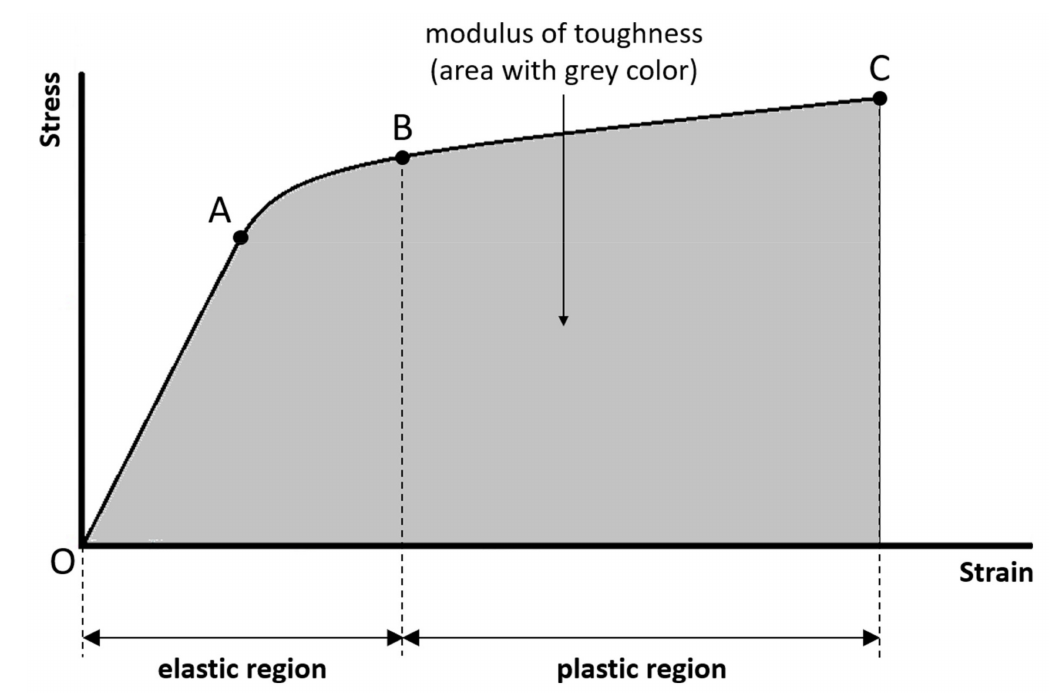
Figure 4. The modulus of toughness is the amount of energy per unit volume necessary to completely break the sample, and is quantified by the area under the entire stress–strain